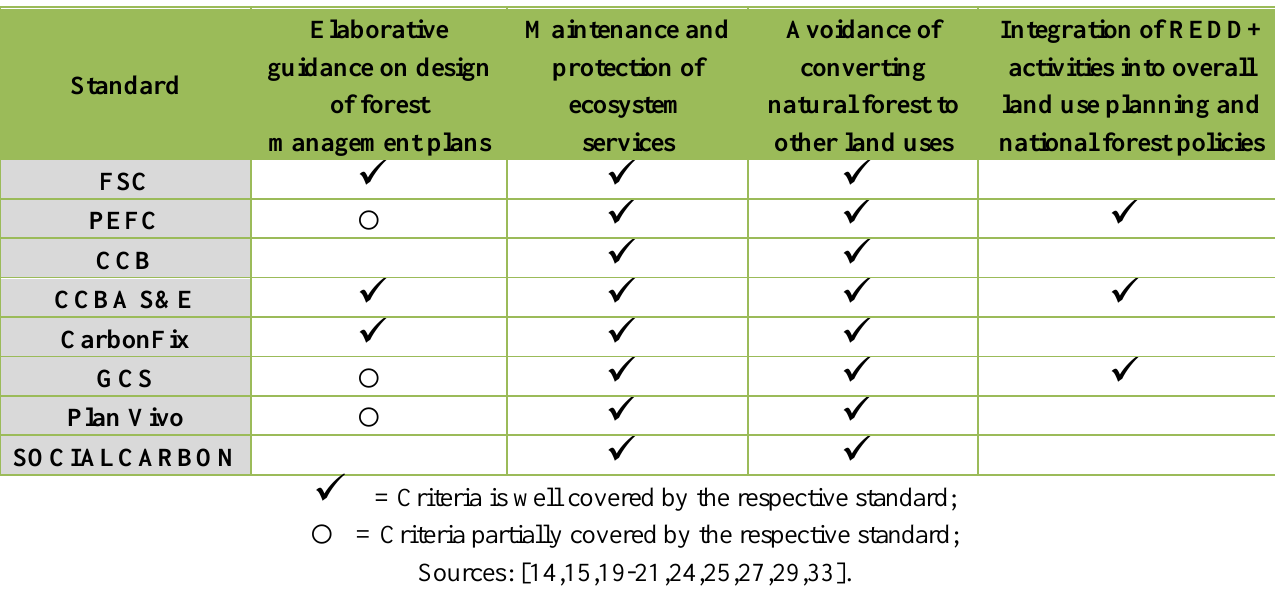
Table 3. Standards’ sustainable management of forests